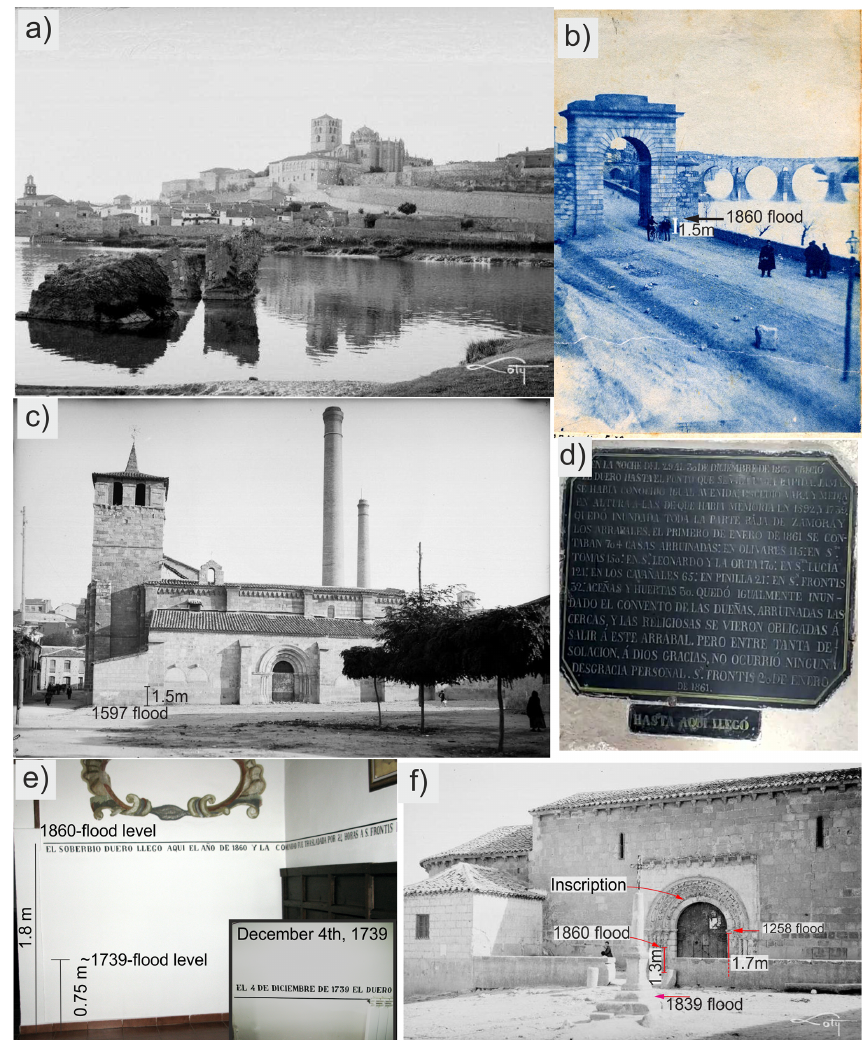
Figure 4. Photos illustrating flood epigraphic marks and sites referred to in written flood reports. (a) View towards the cathedral (centre uphill) with remnants of the old bridge destroyed by a flood in 1310. At the left opposite river margin are the Olivares mills and the tower of the San Claudio church (photo by António Passaporte, 1927–1936; source: Loty Archive-02471, historic heritage photo, http: //www.mcu.es/fototeca_patrimonio, last access: 24 November 2021). (b) View of the Gate of Pescado, where an epigraphic mark was 1.5m from the gate base (source: Historical Provincial Archive). (c) View of Santa Maria de la Horta reached by floods at least in 1597 and 1788 (photo by António Passaporte, 1927–1936; source: Loty Archive-02479, historic heritage photo, http://www.mcu.es/fototeca_patrimonio, last access: 24 November 2021). (d) Epigraphic mark of the 1860 flood in San Frontis church. The description states that the 1860 flood was the largest of the last 3 centuries. (e) Epigraphic flood mark of the 1860 flood in Las Dueñas convent at the refectory of the convent: “The magnificent Duero River reached here in 1860, and the community had moved for 24 hours to San Frontis”. Inset: epigraphic mark of the 1739 flood in Las Dueñas convent in the same dining room but ca. 1m lower than the 1860 mark. (f) View of San Claudio church between 1927 and 1936. The inscription in the arc refers to the “bad years of 1258” contemporaneous with the one at the upper doorpost pointing to a flood (Marquina, 1949a). At the pedestal of the cross was an inscription to the 1839 flood, which disappeared after restoration work (photo by António Passaporte; source: Loty Archive-02464, historic heritage photo http://www.mcu.es/fototeca_patrimonio, last access: 24 November